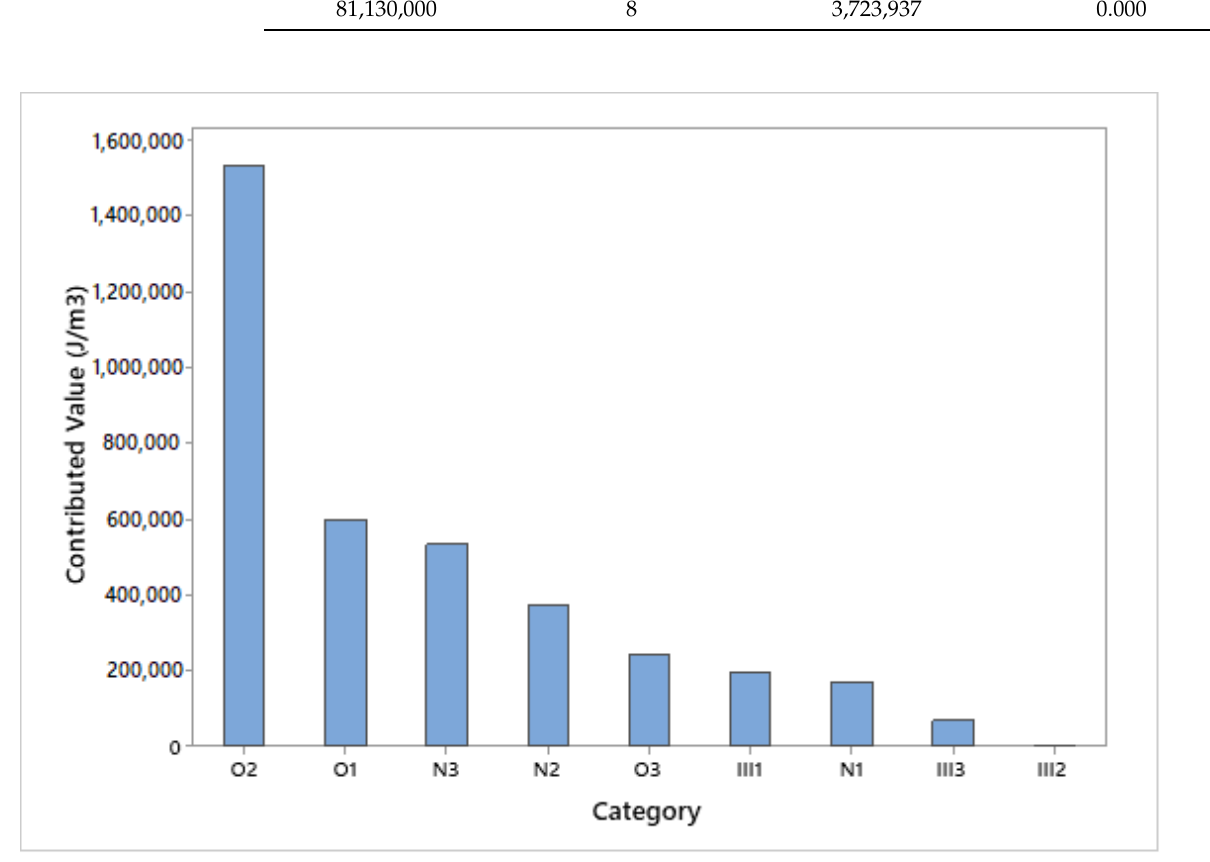
Figure 13. Contribution of tested samples to the chi-squared value.